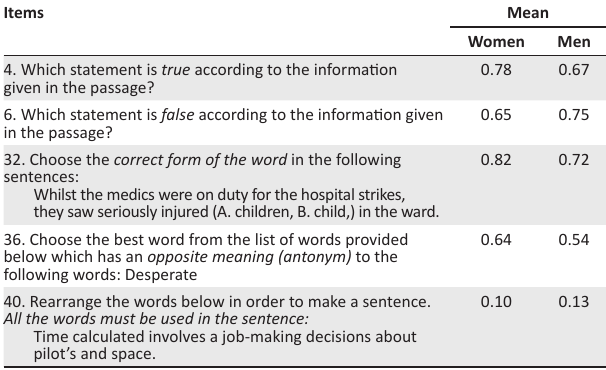
TABLE 5: Statistically different items for English Comprehension Test version